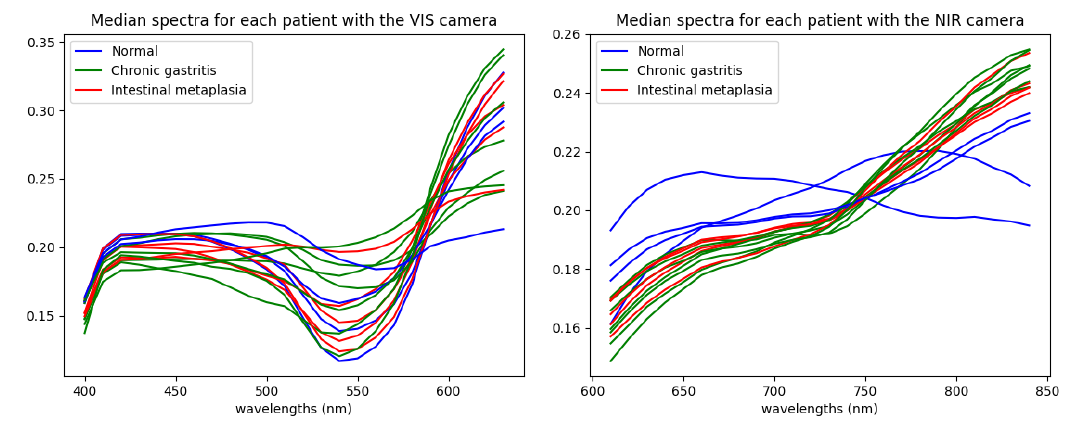
Figure 4. Acquisitions with VIS and NIR